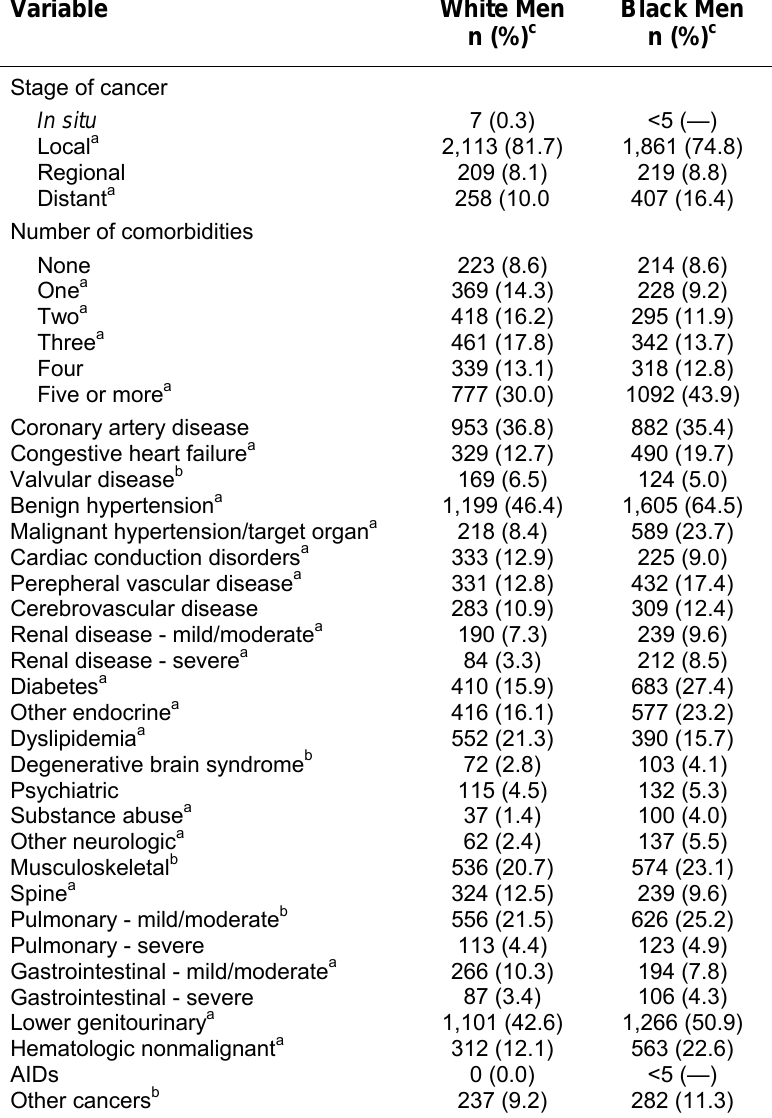
Characteristics of Prostate Cancer Study Sample by Race Based on SEER Program; Medicare Linked File, Patients Diagnosed 1993–1995